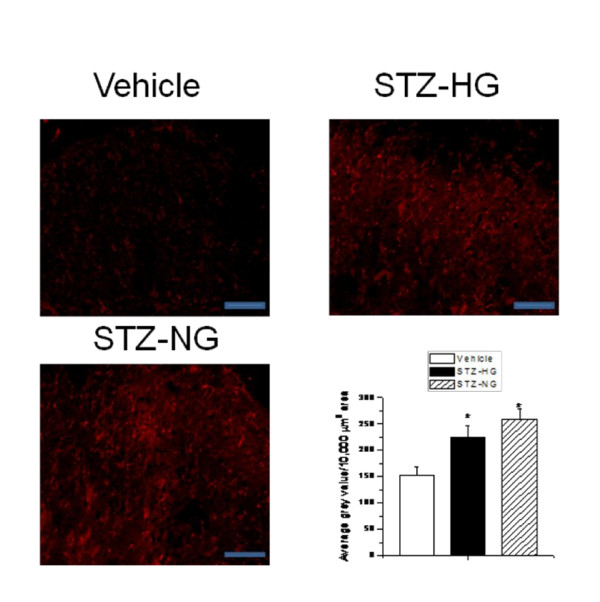
Altered microglial activation in spinal cord dorsal horn of STZ-treated rats. A. Representative images of OX-42 staining (marker for microglial activation) from a vehicle-treated, STZ-HG and STZ-NG rats. B. Average gray values/10,000 μm2 area of OX-42 staining in spinal dorsal horn was significantly increased (p < 0.05) in both STZ-HG and STZ-NG rats as compared to vehicle-treated rats. Asterisk (*) represents p < 0.05. Scale bar is 50 μm.